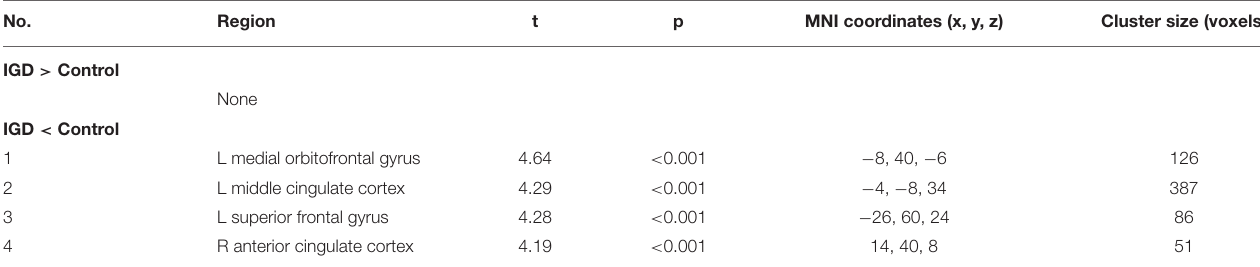
TABLE 2 | Differences in regional cerebral metabolic rate of glucose between participants with Internet gaming disorder and controls. No.